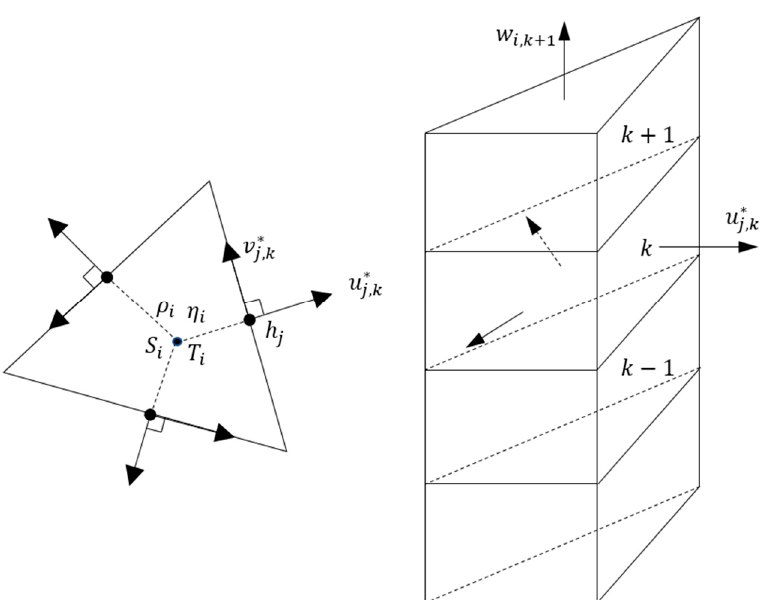
Figure 2. Location of computational variables, where η i , ρ i , S i , and T i denotes the water surface elevation, water density, salinity, and water temperature, respectively, which are defined at the center of the 𝑖 th element; ℎ (cid:3037) is the water depth which is defined at the 𝑗 th side; 𝑢 (cid:3037),(cid:3038)∗ and 𝑣 (cid:3037),(cid:3038)∗ are the face normal and tangential velocities which are defined at the 𝑗 th side; and 𝑘 is the vertical layer index.